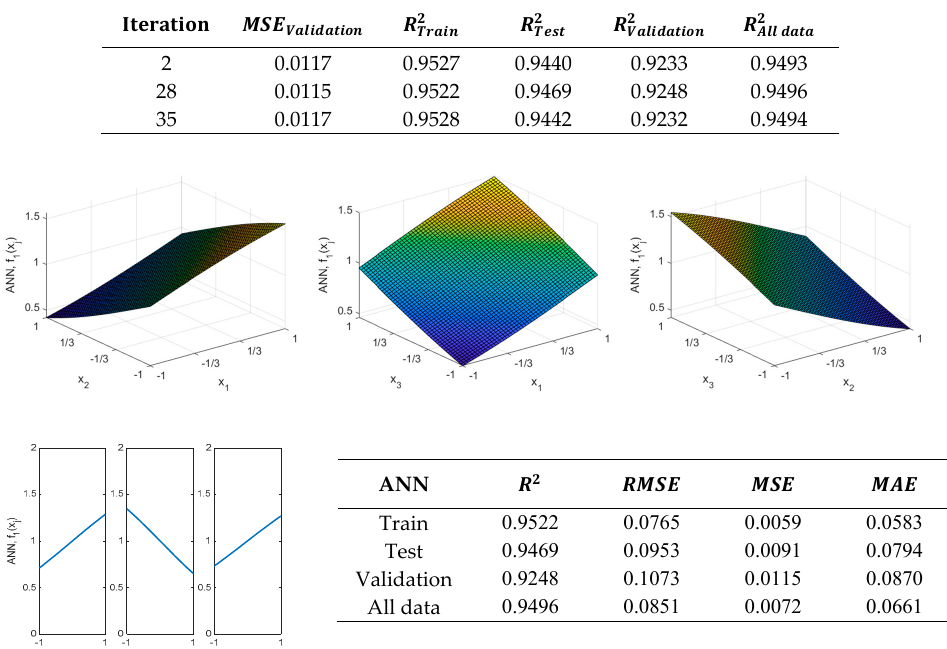
Figure 8. Response surfaces obtained, main effects plot and results of the validation metrics obtained with the ANN model for the case of type 1 function ( f 1 ) ( n = 1 neurons )